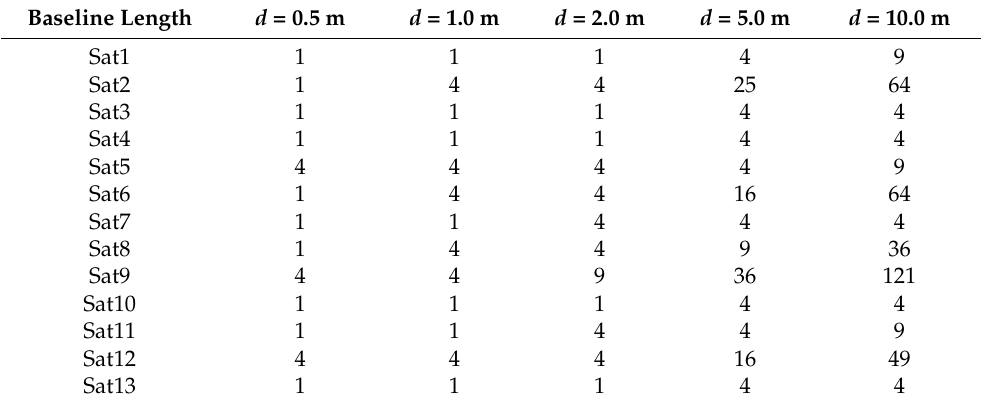
standard deviations.